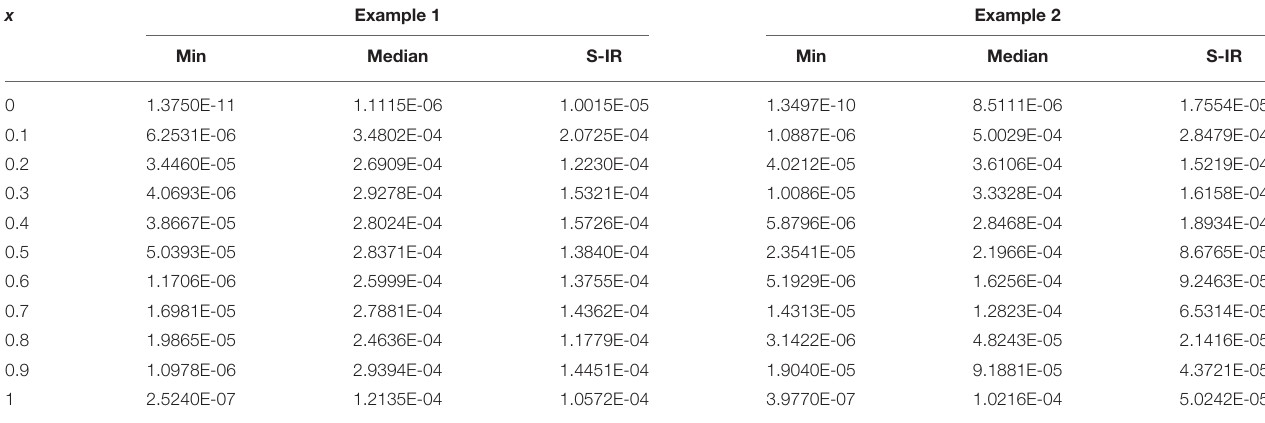
TABLE 3 | Statistical measures of second order SPBVP for 10 numbers of